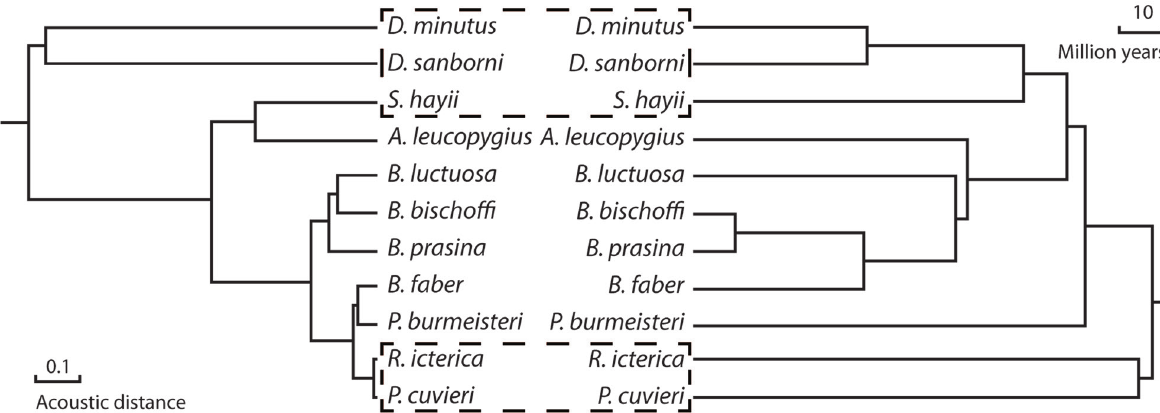
Figure 3. Acoustic distances and phylogenetic relationships of calling males recorded in a permanent pond in Reserva Biológica Municipal da Serra do Japi ( RBMSJ ), Jundiaí municipality, São Paulo State, Brazil. Dendrogram of acoustic distances based on pairwise niche distance matrix of dominant frequencies. Black dashed squares indicate phylogenetic signal for this trait. Abbreviations for genera corresponds to: Aplastodiscus ( A. leucopygius ), Boana ( B. bischoffi , B. faber , B. prasina ), Bokermannohyla ( B. luctuosa ), Dendropsophus ( D. minutus , D. sanborni ), Phyllomedusa ( P. burmeisteri ), Physalaemus ( P. cuvieri ), Rhinella ( R. icterica ), and Scinax ( S. hayii